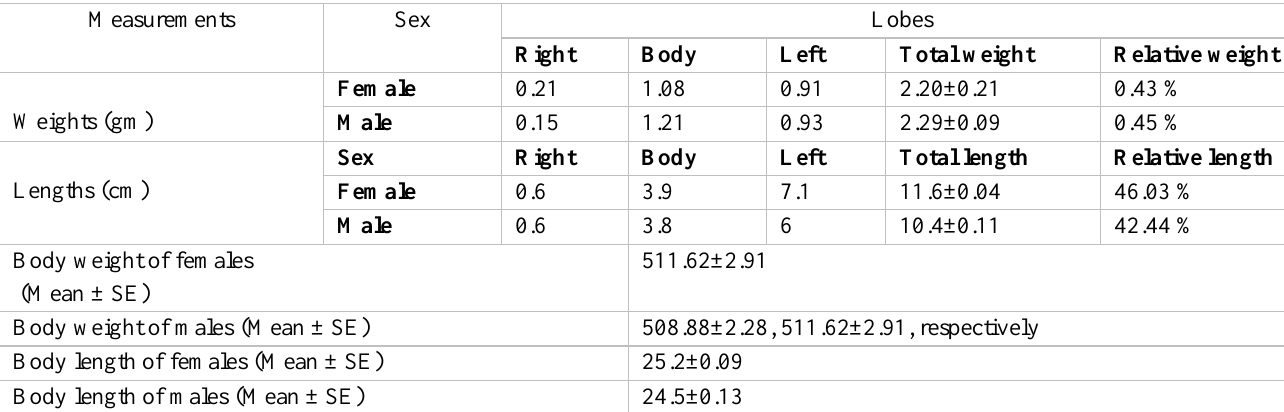
Table 1. Means of weights and lengths of pancreatic lobes in male and female guinea